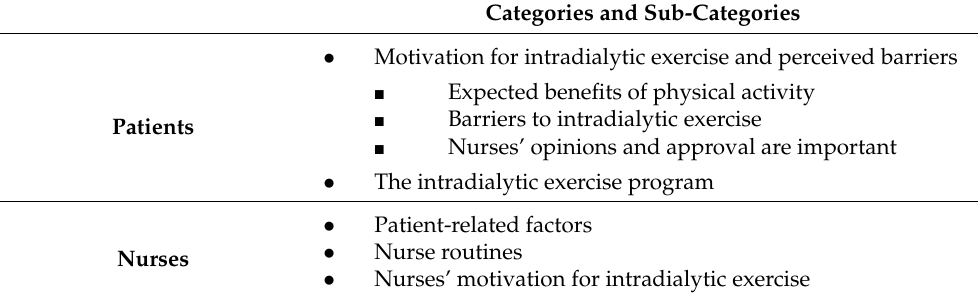
Table 3. Overview of